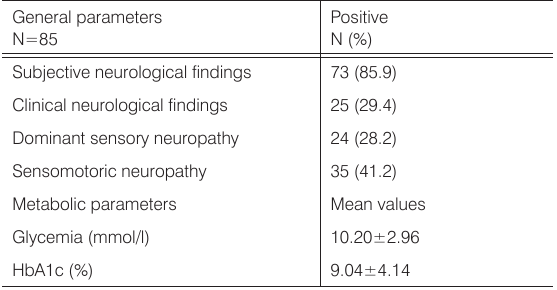
Table 1. Presentation of general and metabolic parameters in evaluated population